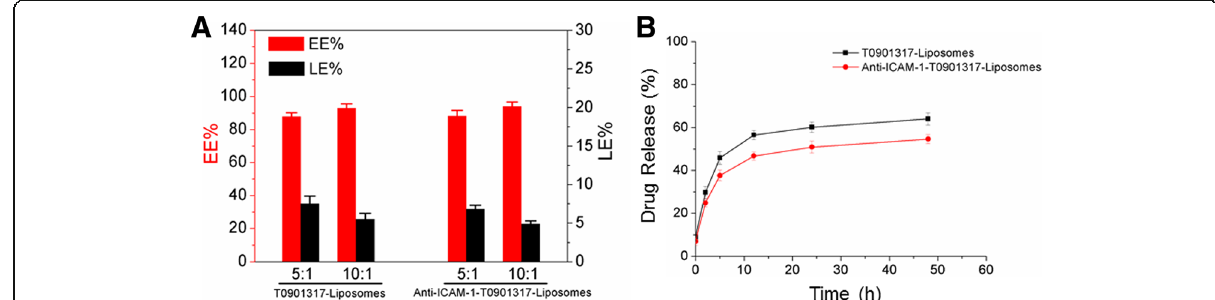
Fig. 3 a Entrapment and loading efficiencies of T0901317- liposomes and anti-ICAM-1-T0901317- liposomes at two lipid to T0901317 weight ra- tios (5:1 and 10:1). b In vitro drug release of T0901317- liposomes ( squares ) and anti-ICAM-1-T0901317- liposomes ( circles ) at different time points. Values are expressed as the means± SD ( n = 3)